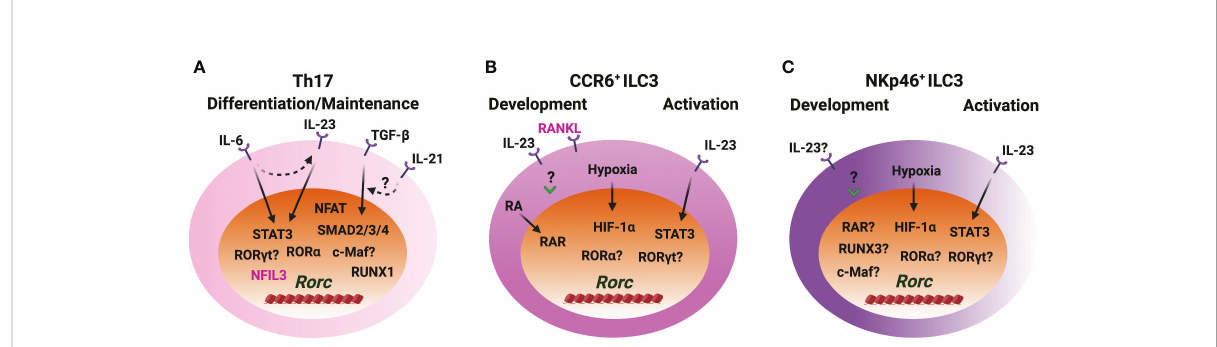
FIGURE 4 ROR g t induction in Th17 cells and ILC3s. (A) IL-6/STAT3 and TGF- b /SMAD signaling induce ROR g t expression through Rorc-CNS-1.5 and Rorc- CNS+6 during Th17 cell differentiation. IL-23/STAT3 plays a role in ROR g t expression when IL-23R is upregulated upon naïve CD4 T cell activation. IL-21 synergizes with TGF- b to upregulate ROR g t. ROR a and ROR g t bind to Rorc-CNS-11 and play important roles in maintaining ROR g t levels in Th17 cells. NFIL3 represses ROR g t expression in CD4 T cells. (B, C) IL-23 upregulates ROR g t expression during CCR6 + ILC3 development in vitro , but STAT3 is dispensable for ROR g t expression during ILC3 development in vivo . IL-23/STAT3 signaling regulates ROR g t expression in mature ILC3s. Hypoxia induced HIF-1 a regulates ROR g t expression in ILC3s. RA receptor RAR binds to the Rorc gene locus and regulates ROR g t expression during CCR6 + ILC3 development and ILC3 activation. RUNX3 is critical for the ROR g t expression in NKp46 + ILC3s. The role of ROR a and ROR g t in regulating ROR g t expression in ILC3s is unclear. c-Maf bene fi ts ROR g t levels, but whether this is a direct effect is unknown. RANKL represses ROR g t expression in CCR6 +